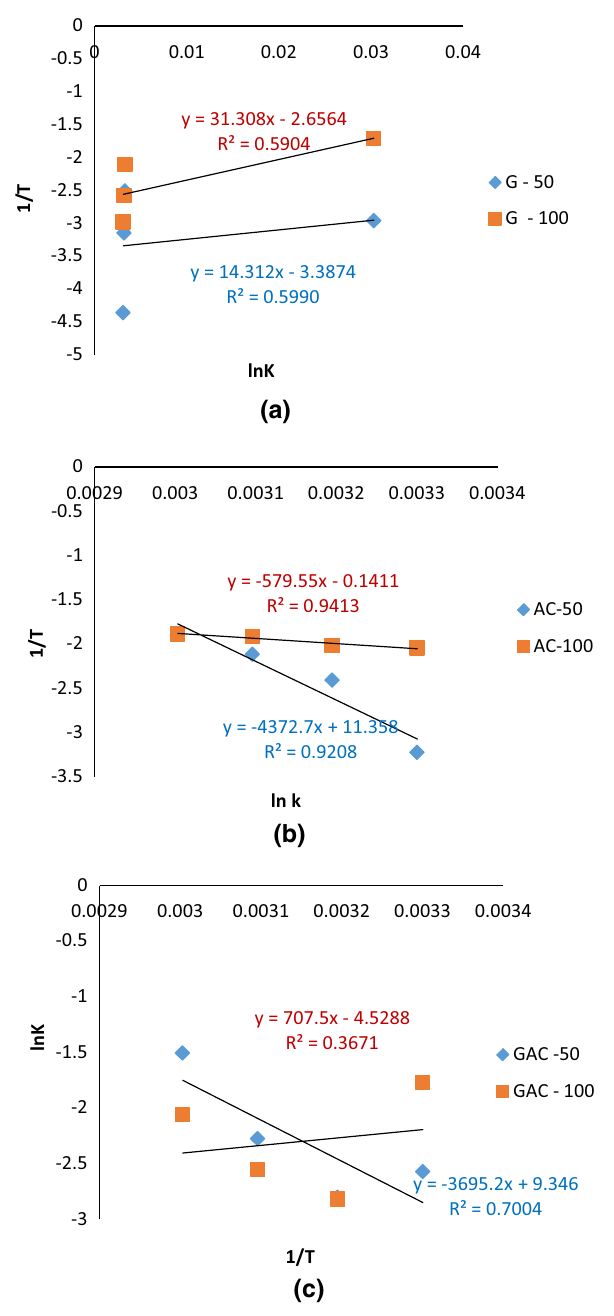
Fig. 17 a Thermodynamic plot of Cr(VI) adsorption onto goethite (G), b thermodynamic plot of Cr(VI) adsorption onto activated car- bon (AC), c thermodynamic plot of Cr(VI) adsorption onto G–AC